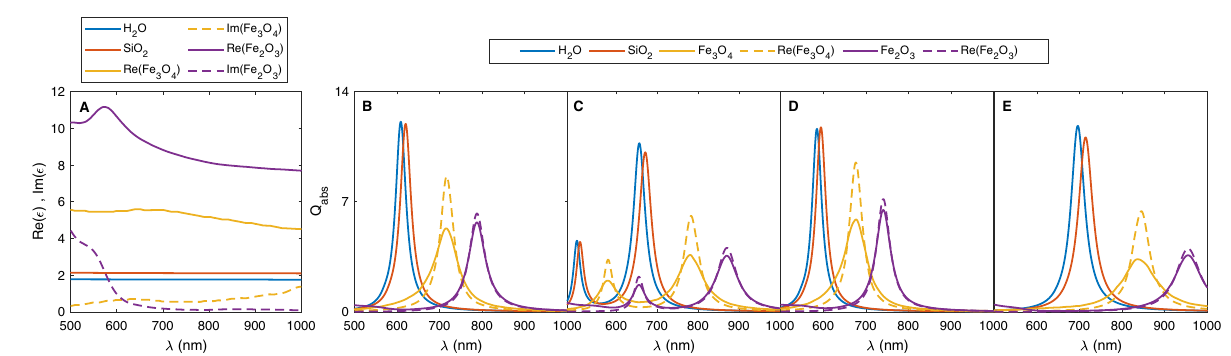
Figure 6. ( A ) Dielectric function of water, silica, magnetite and hematite. LSPR spectra of ( B ) CS, ( C ) NE, ( D ) PS and ( E ) OS with core materials of water, silica, magnetite and hematite. The total radius of the nanoshell is 25 nm and the core occupies 51% of the